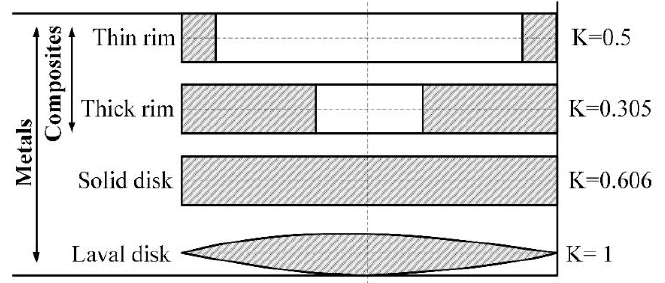
Figure 11. Different flywheel cross sections with differing values of the shape factor K [42]. Figure 11. Di ff erent flywheel cross sections with di ff ering values of the shape factor K